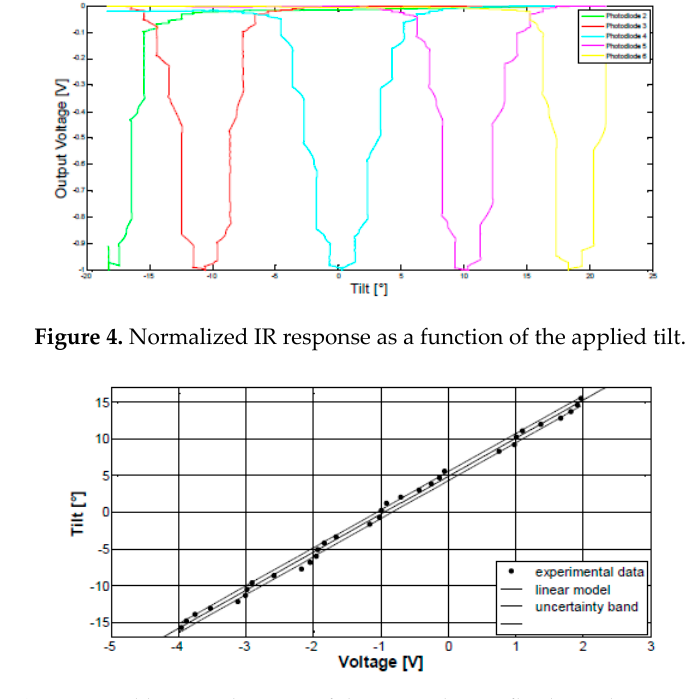
Figure 5. Calibration diagram of the Optical Ferrofluidic